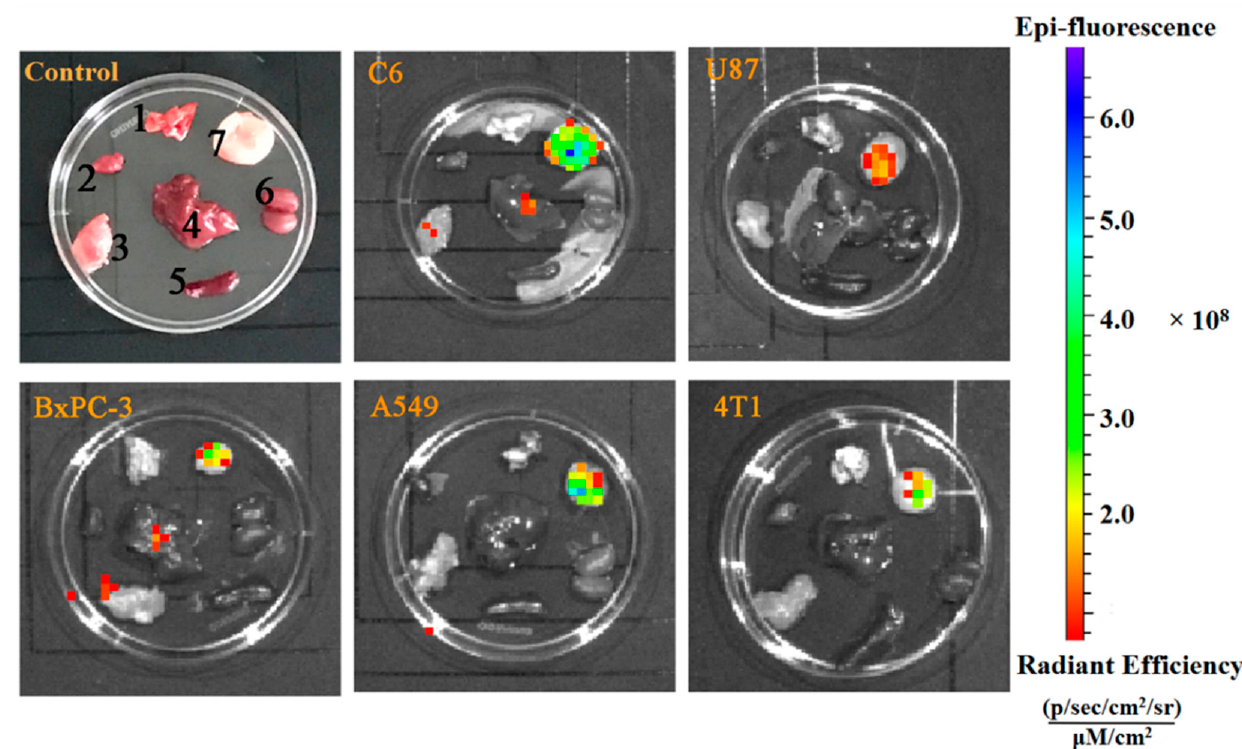
Figure 4. Ex vivo fluorescent images of tumor-bearing mice (U87, C6, A549, 4T1, and BxPC-3) at 1 h post-injection of FITC-PTP. C6 tumor-bearing mice treated with PBS were set as the control group. Samples were (1) lung, (2) heart, (3) muscle, (4) liver, (5) spleen, (6) kidneys, and (7) tumor, respec- tively.